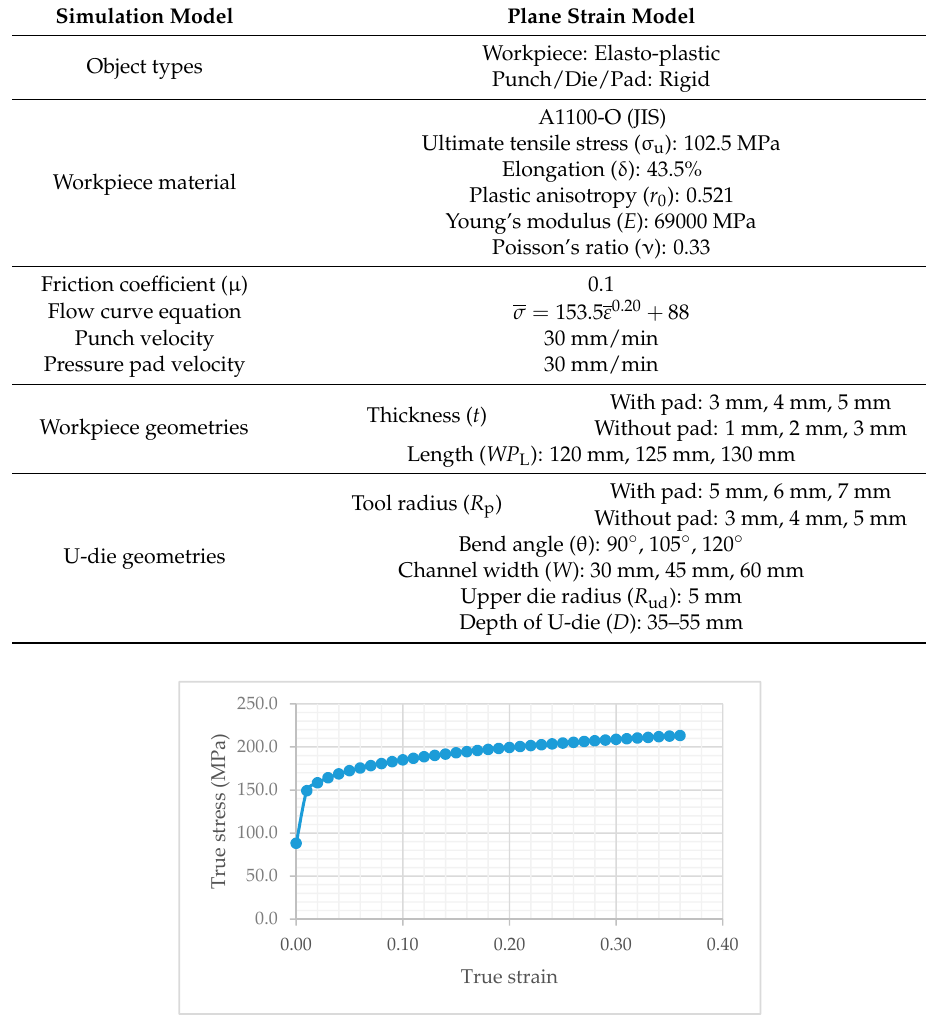
Table 1. FEM simulation and experimental conditions.